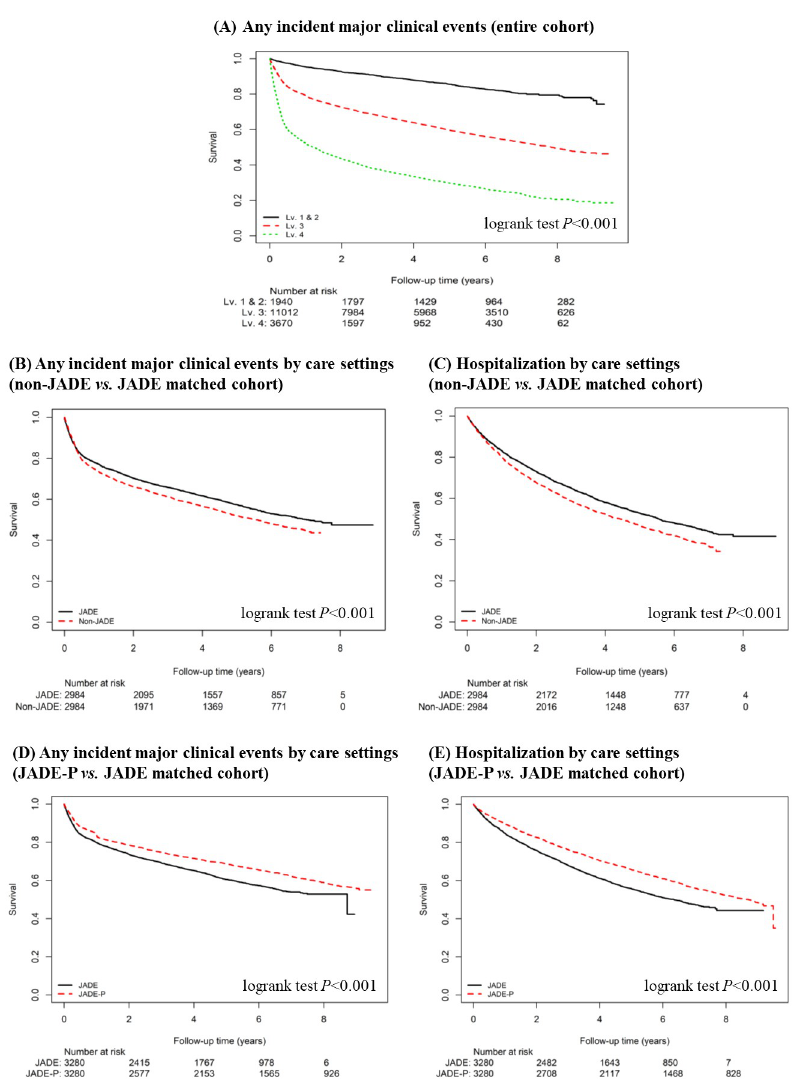
Fig 4. Kaplan-Meier plots showing the survival probabilities of the first occurrence of any major clinical events in the entire cohort, stratified by JADE risk levels (A), and the first occurrence of any major clinical events and hospitalization in the propensity-score–matched cohorts (B–C: non-JADE versus JADE; D–E: JADE-P versus JADE). The non-JADE group underwent publicly funded evaluation. The JADE group received publicly funded evaluation with JADE report and group education. The JADE-P group received self-paid evaluation with JADE report, personalized empowerment, and annual phone reminder for engagement. Any major clinical event was defined as the first occurrence of either CHD, PVD, stroke, heart failure, CKD, ESRD, all-site cancer, or all-cause death. Hospitalization was calculated for patients with at least an overnight stay. Definitions of JADE risk levels [20]: Level 1: No CVD and ESRD; and having other condition fulfilling the “Low-risk” (one or less stratification parameters, and risk scores below the high sensitivity cut-off in all of the risk equations and eGFR � 90 mL/min/1.73 m 2 ). Level 2: No CVD and ESRD; none of the conditions (risk score, stratification parameters, eGFR) defined in the “High-risk” category but not belonging to the “Low-risk” category. Level 3: No CVD and ESRD and having 3 or more stratification parameters and/or risk scores above the high specificity cut-off in any one of the risk equations and/or eGFR < 60 mL/ min/1.73 m 2 . Level 4: Presence of any CVD (CHD, heart failure, stroke, and/or PVD with or without interventions or medications) and/or ESRD (eGFR < 15 mL/min/1.73 m 2 or need for renal replacement therapy). CHD, coronary heart disease; CVD, cardiovascular disease; eGFR, estimated glomerular filtration rate; ESRD, end-stage renal disease; JADE, Joint Asia Diabetes Evaluation; JADE-P, JADE-Personalized; Lv, Level; PVD, peripheral vascular disease.